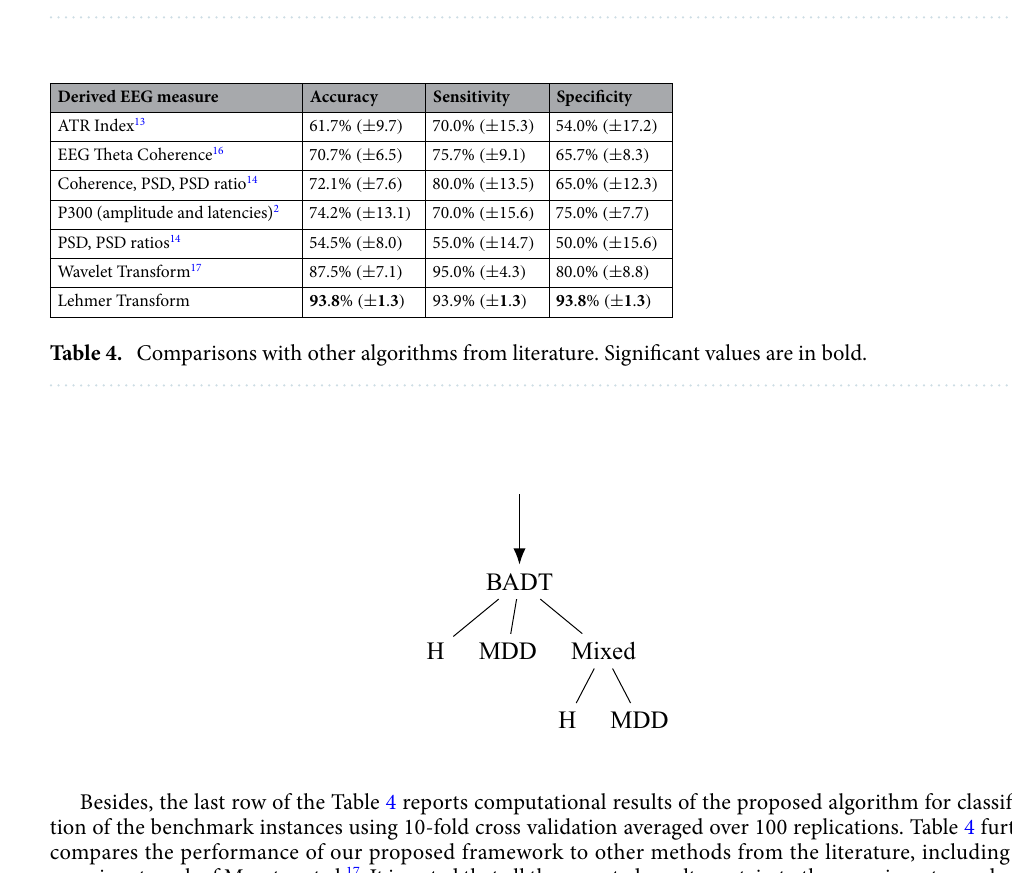
Table 3. Comparisons with different incorporated classifiers.